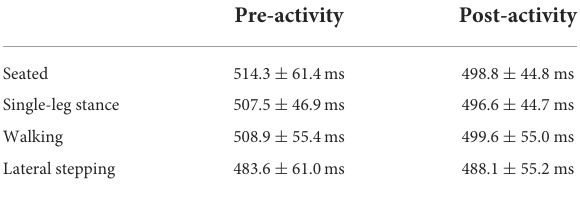
TABLE 1 Means and standard deviations for reaction time flanker variable for all motor conditions before and after exercise.